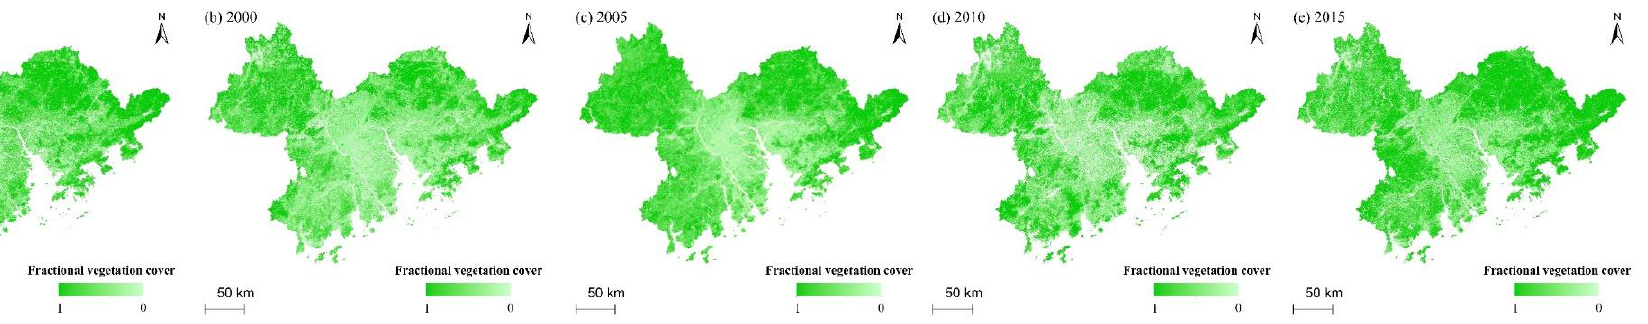
Figure A4. The spatial pattern of fractional vegetation cover in ( a ) 1995, ( b ) 2000, ( c ) 2005, ( d ) 2010, and ( e ) 2015. The terrestrial ecosystem classification data was obtained from RESDC and is shown in Figure A5. These data were classified into farmland, forest, grassland, water and wetland, settlement, desert, and other ecosystems.